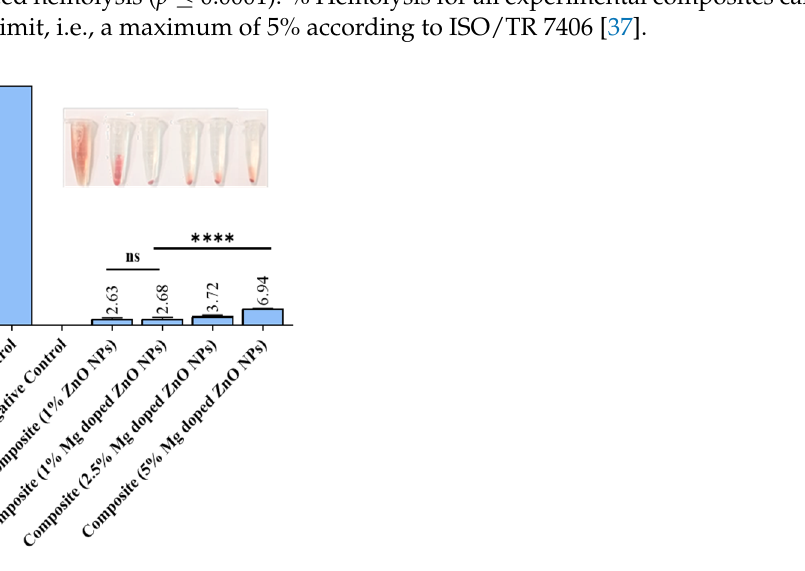
Figure 7. % Hemolysis of composites with bare and Mg-doped ZnO NPs at varying concentrations. p -value < 0.0001 is flagged with four stars (****), while ns (not significant) represents statistically insignificance.